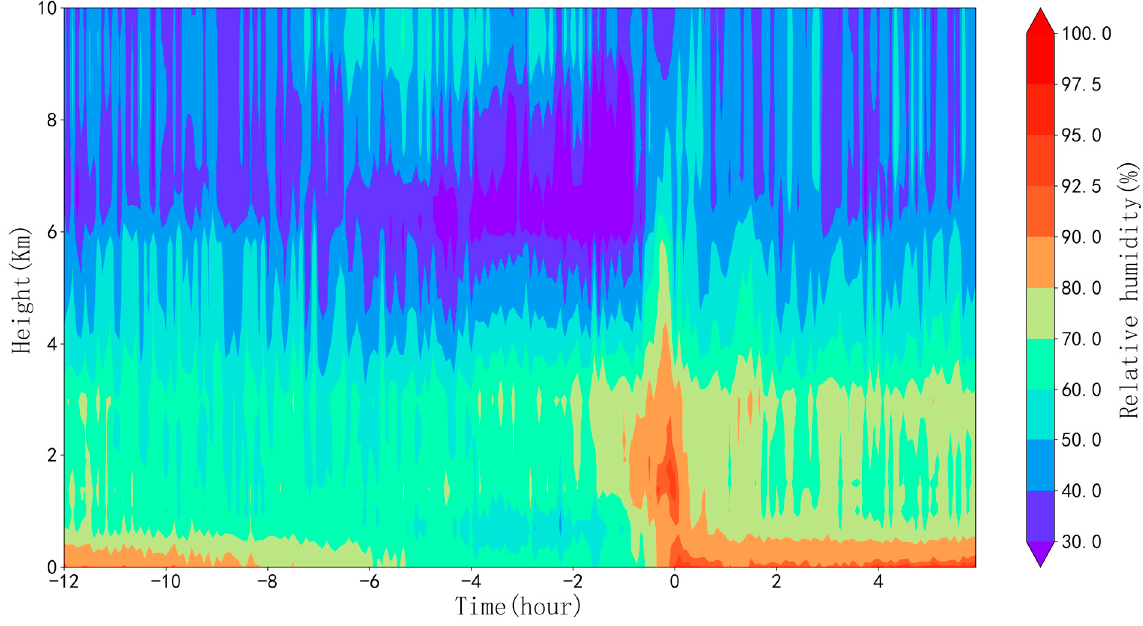
Figure 5. Vertical distributions of relative humidity during 12 h before and 6 h after the start of SDPs in 2021.